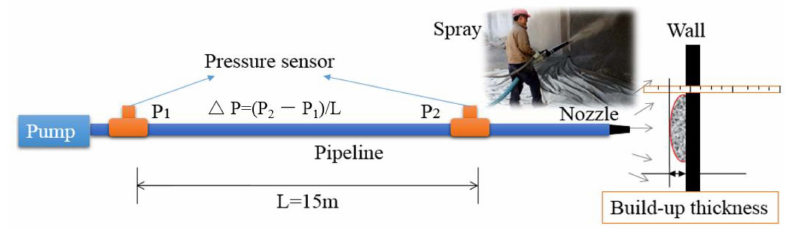
Figure 2. Pumping and shotcreting tests of fresh